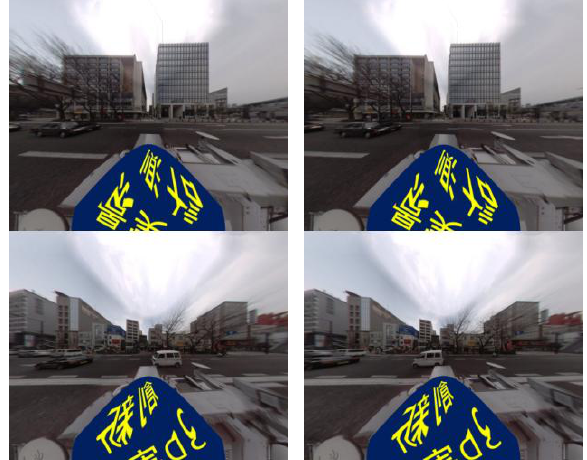
Figure 10. Both middle parts of the resampled stereo panoramic epipolar images with the standard perspective